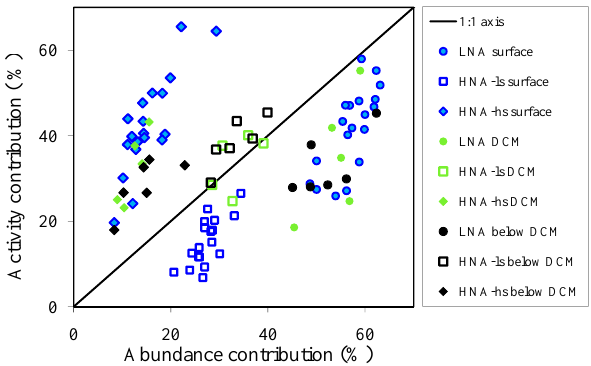
Fig. 7. Relationship between abundance contribution of HNA-hs, HNA-ls and LNA groups to their summed abundance and volumet- ric rate contribution for the same groups to their summed volumetric rates. The line represents the 1:1 axis.